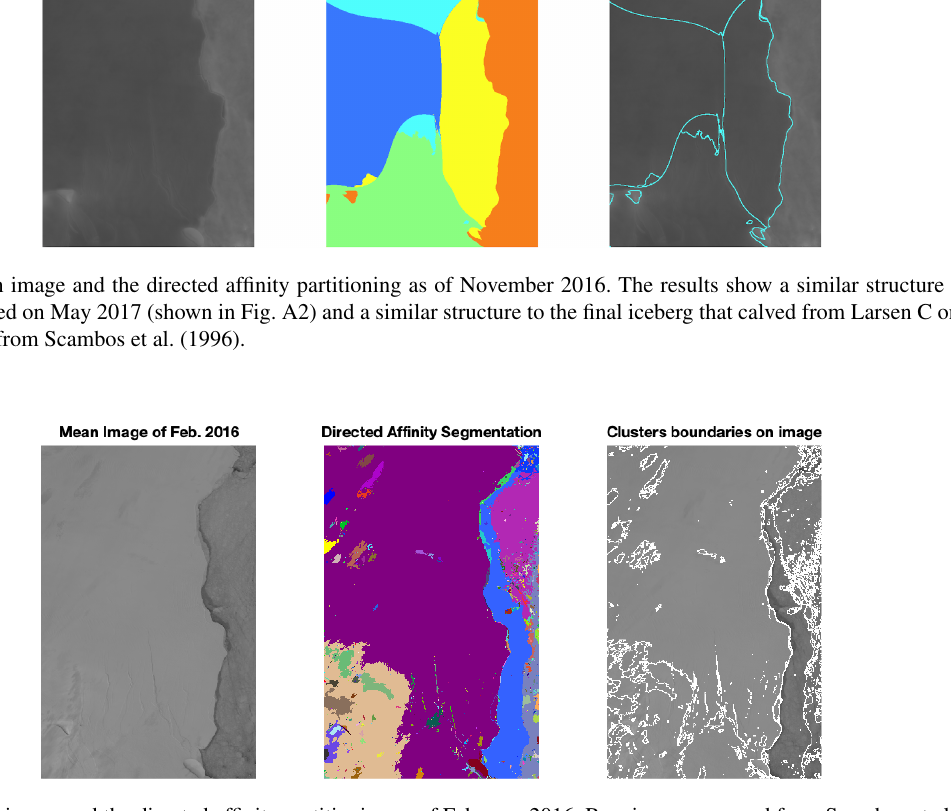
Figure B3. The mean image and the directed affinity partitioning as of February 2016. Raw images sourced from Scambos et al.